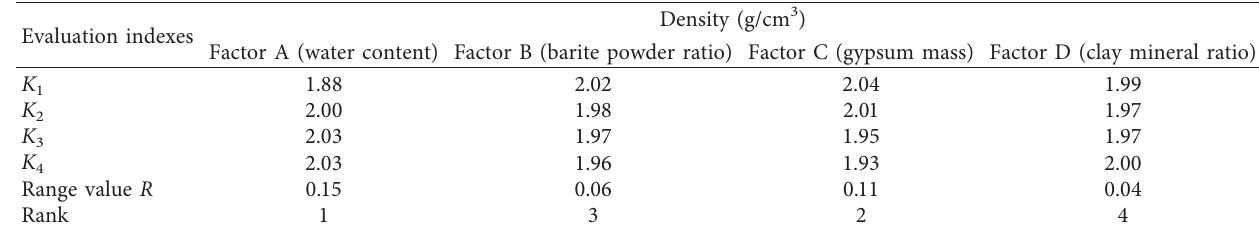
Table 8: Range analysis of rock density.